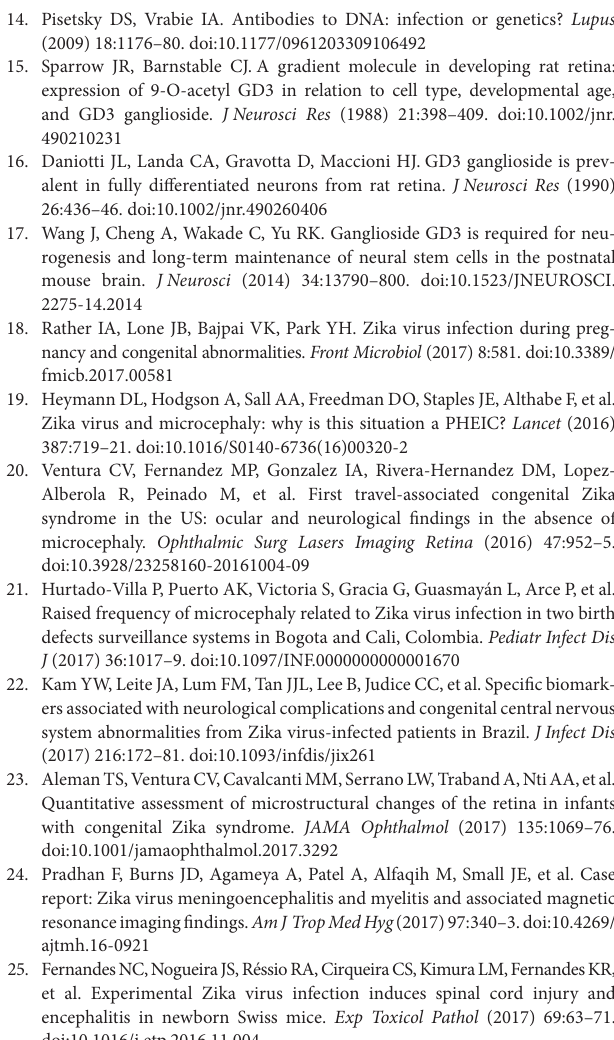
FigUre s1 | ELISA for the detection of anti-GD3 antibodies. ELISA plates were coated with GD3 and incubated with serial dilutions of Zika–infected samples,